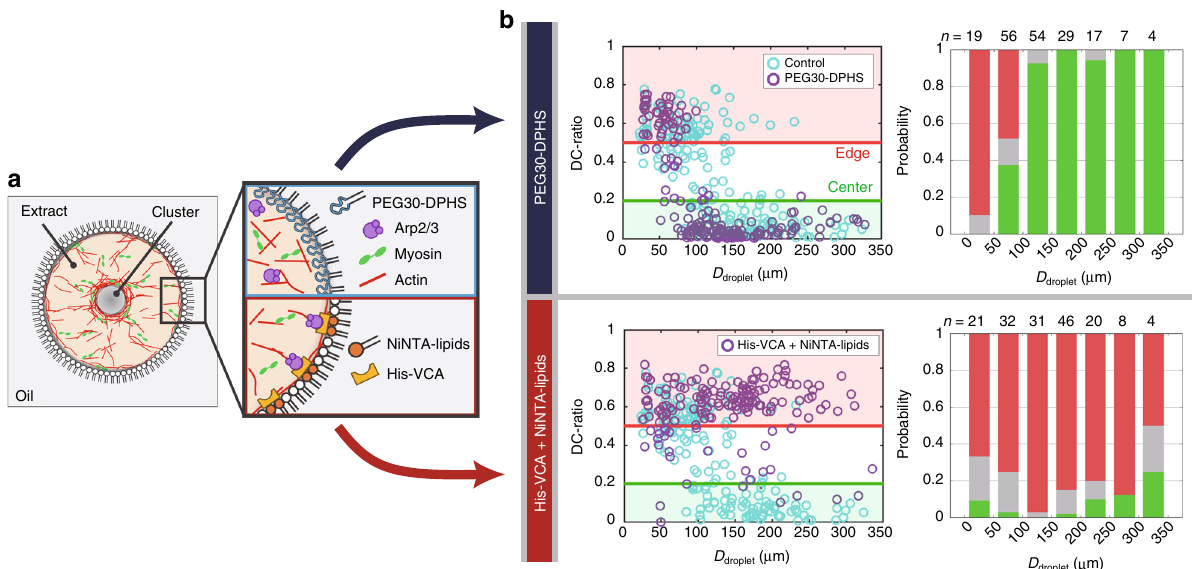
Fig. 3 Modulations of the surface property alters the cluster positioning. The interaction between the droplet boundary and actomyosin networks in the bulk space was modulated by changing the surface property. a Schematic illustration showing alternations of the surface property of droplets. (Top) PEG30-DPHS, a polyethylene glycol (PEG)-based surfactant, will decrease physical interactions of bulk actomyosin networks with the droplet boundary. (Bottom) The VCA domain of WASP conjugated with a histidine-tag was anchored to the droplet boundary via Ni-NTA-conjugated lipids. VCA recruits Arp2/3 and activates its actin nucleation activity. Thus, it was expected that interactions of bulk actomyosin networks with the droplet boundary increased. b The edge-positioned probabilities were compared between different surface properties. Cyan circles show the control data (egg PC). (Top) Passivated droplet surface promoted the cluster centering, whereas (bottom) activated droplet surface promoted the edge positioning. Kolmogorov – Smirnov test was applied to the scatter plots of DC-ratio between D droplet = 50 μ m – 150 µ m (around the transition point in the control experiment). The distributions were signi fi cantly different from the control in both conditions ( p < 0.001). We performed two independent fi nely evaluate this D fi tted the analytical expression for c , we the edge probability, derived from the tug-of-war model later (see “ Methods ” section for details), to a set of data. Addition of the actin crosslinker α -actinin increased the